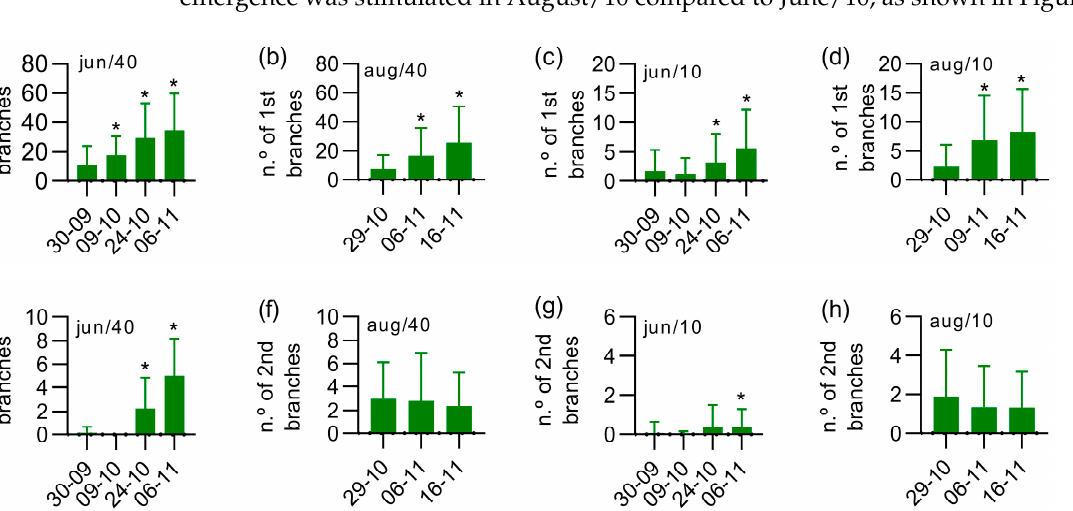
Figure 4. Behavior of branches’ emergence during the vegetative development of yerba-mate plants from pruning under four experimental conditions. The data are represented as mean ± standard deviation of at least 80 measurements. The plants were coppiced in 2019/June or 2019/August, as specified in the graphs. * p < 0.05 in relation to the first measurement according to Kruskal–Wallis analysis followed by Dunn’s test. During this period, the temperature was 20.29 ± 6.06 °C (36.3–4.3 °C) and the rainfall was 313 mm, according to data from a local meteorological monitoring service.